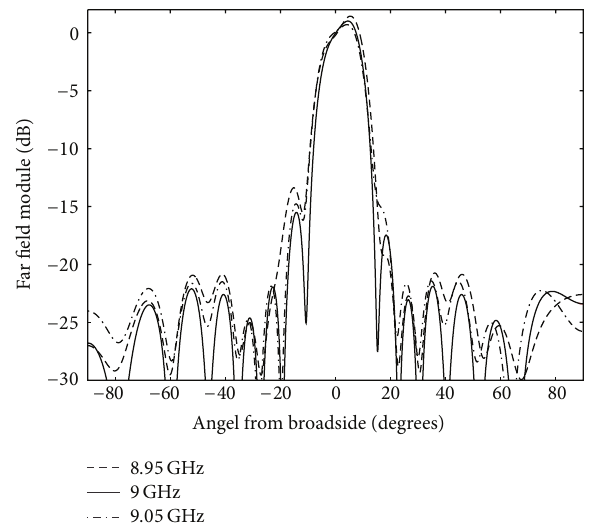
Figure 18: Simulated 𝐻 -plane far field of the 10 × 10 array with an arrow-shaped radiation